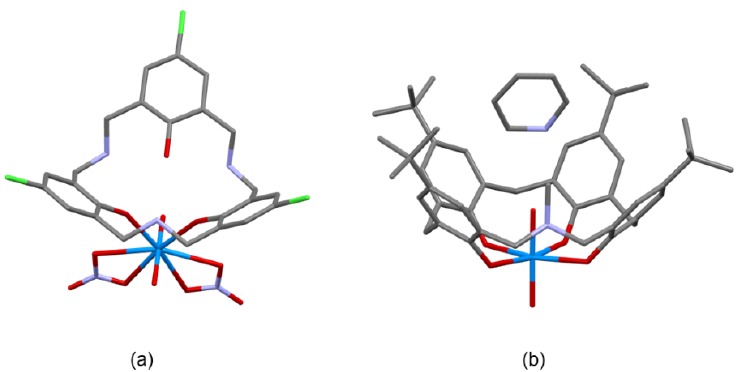
Figure 8. Structures of the metal complexes of the azacalixarenes. ( a ) UO 22+ [ p -Cl- N -benzyl- triazacalix[3.3.3]arene]. ( b ) UO 22+ [ p-tert -butyl- N -methyl-azacalix[3.1.1.1]arene] · pyridine inclusion complex. Benzyl side chains are omitted for clarity.